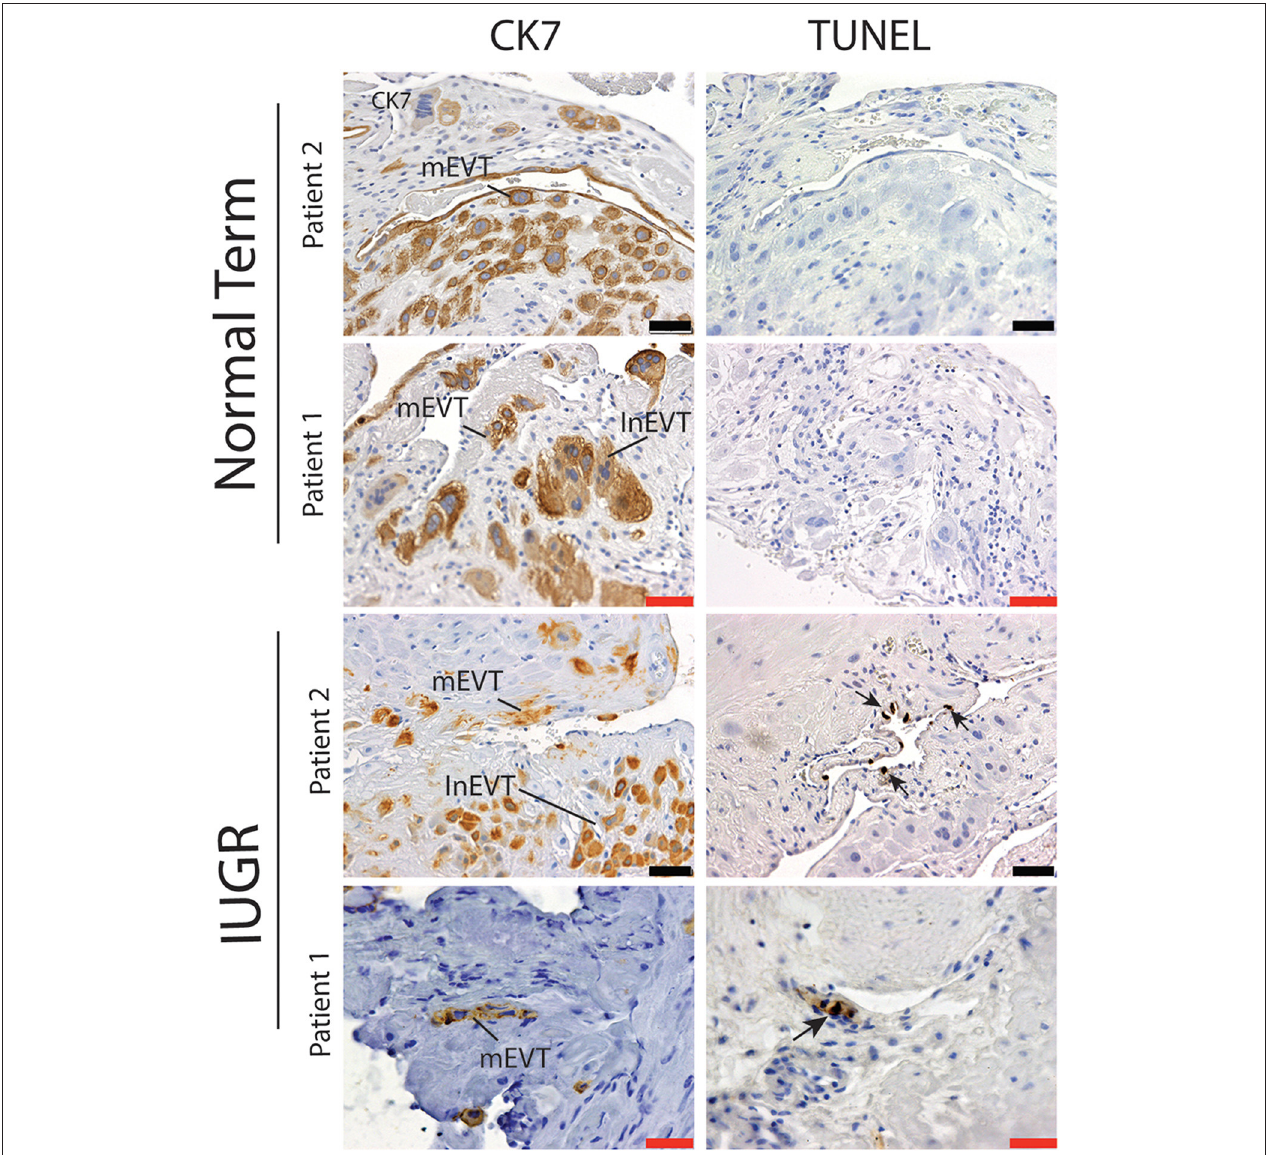
FIGURE 3 | Failed uterovascular transformation in IUGR is associated with the presence of apoptotic mural EVT. Immunohistochemical staining for cytokeratin 7 (CK7, Column 1) and Terminal deoxynucleotidyl transferase dUTP nick end labeling (TUNEL, Column 2) was perfomed to confirm that the fragmented mural EVT that we observed in the IUGR cases were apoptotic. Representative serial sections of control ( n = 2/15) and IUGR PBBx ( n = 2/8) uterine spiral arteries at the decidual myometrial junction are shown. Arrows indicate the TUNEL positively nuclei of the mural EVT (mEVT) showing cytokeratin loss in the matching serial sections in the IUGR samples. No TUNEL staining was seen in the interstitial EVT (inEVT) of the IUGR cases or any of the EVT populations of the control term samples. Scale bars: black = 50 µ M, 100x magnification; red = 20 µ M,